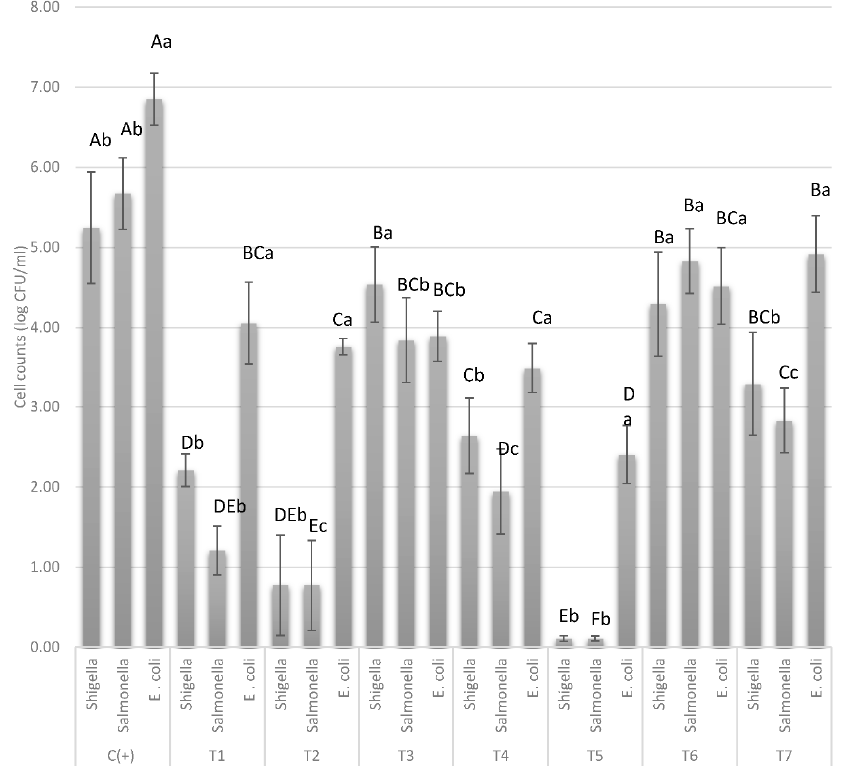
Figure 3. Viability of Shigella, Salmonella, and E. coli in mango wedges at day 5 of storage with refrigeration. The results are expressed in log CFU/g. Legend: Control (+): mango wedges + FSBM; T1: (Cys5-4+ Gt28)CFS: 1:1 ( v/v ); T2: (Cys5-4+ Gt28) CFS: 1:3 ( v/v ); T3: (Cys5-4+ Gt28)CFS: 3:1 ( v/v ); T4: (Cys5-4+ Gt28)PP: 1:1 ( v/v ); T5: (Cys5-4+ Gt28)PP: 1:3 ( v/v ); T6: (Cys5-4+ Gt28)PP: 3:1 ( v/v ); T7: Nisin (50 µ g/mL); FSBM-five-strain bacterial mixture; CFS-cell-free supernatant; PP: partial precipitated peptides. The bars represent the mean ± SD of three independent repetition. The capital letters represent the significant decrease ( p < 0.05) of each target bacterial cells vs control (+). Small letters represent the difference between targets exposed at different treatments. The values with different subscripts (a, b, c) indicate a significant difference ( p <